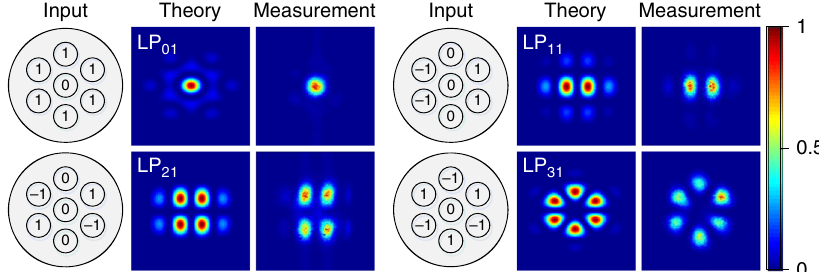
Fig. 4 Scalar LP mode generation. Idealised complex amplitudes of the individual cores required to generate speci fi c LP fi bre modes and the corresponding beam pro fi les in the far- fi eld (in theory and rotated by 90°, a similar doughnut-shaped beam was obtained but an azimuthally polarized vector beam was created as shown in Fig. 5e, f. In this case, orientation of the two lobes is perpendicular to the transmission axis of the linear polarizer.